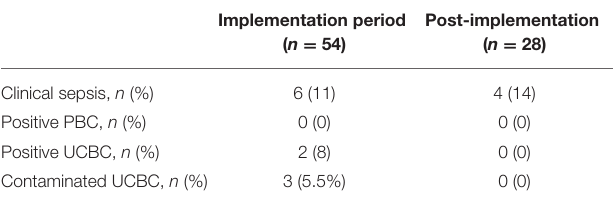
FIGURE 1 | (A) UCBC contamination rate P chart demonstrating special cause variation with a reduction of contamination from 7.3 to 0%. (B) Antibiotic duration in all neonates P chart demonstrating variability but no change in the average duration of antibiotics during this initiative. (C) P chart showing antibiotic duration specifically in asymptomatic neonates did not change during the initiative. The black dotted line denotes upper and lower control limits, solid gray line denotes the center line, solid black line denotes average per month. CL, center line (mean); LCL, lower control limit; PDSA, plan do study act; UCL, upper control limit. *months with contaminated samples. TABLE 3 | Culture results in implementation compared to post-implementation